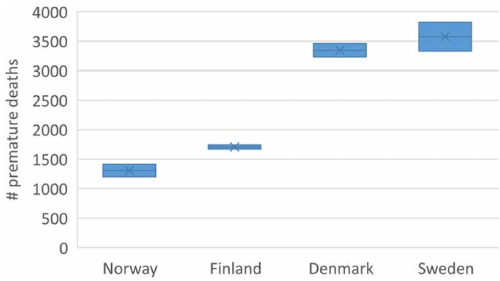
Figure 5. Premature deaths attributable to NO 2 , O 3 , SO 2 and PM 2 . 5 exposure in the four largest Nordic countries in the base case for 2015 (including all of the main anthropogenic emission sources). The results are given as box plots, where the “x” indicates the cen- tral estimate and the size of the box shows the difference between the DEHM-EVA and MATCH-EVA assessments.